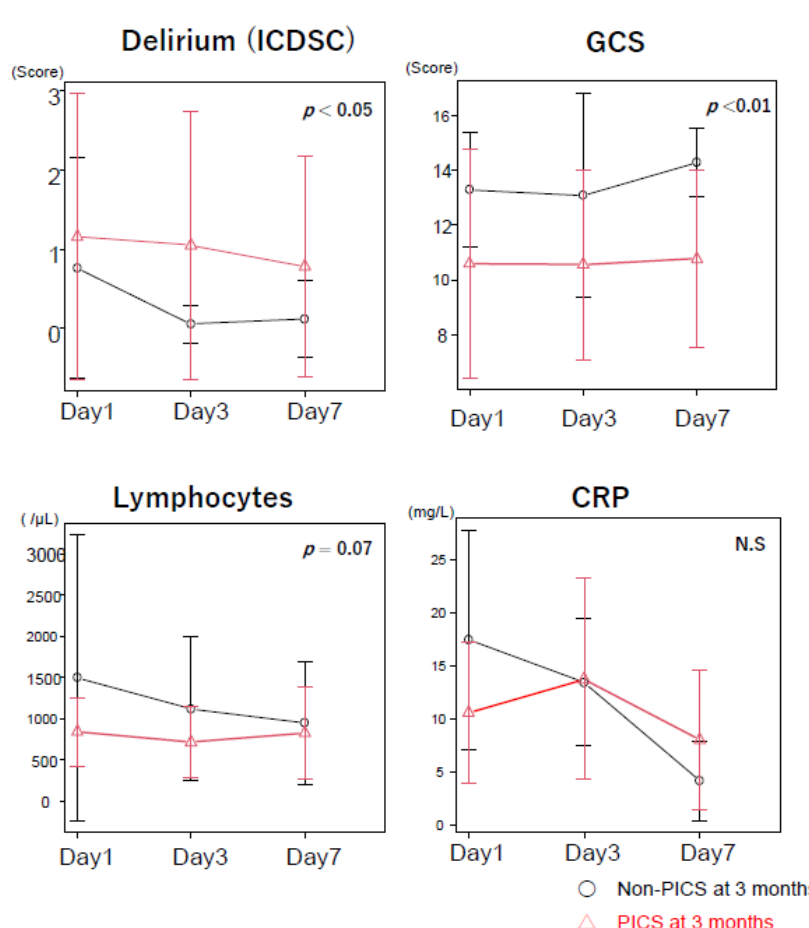
Figure 4. Changes in the ICDSC score, GCS score, number of lymphocytes, and serum CLP levels between participants with PICS at 3 months and those in the non-PICS group at 3 months. Results are presented as mean ± SD values. PICS: post-intensive care syndrome; GCS: Glasgow Coma Scale; ICDSC: Intensive Care Delirium Screening Checklist. CRP: C-reactive protein. Table 4. Detection rate and strains from blood cultures and first antibacterial and antifungal agents used. Enrolled